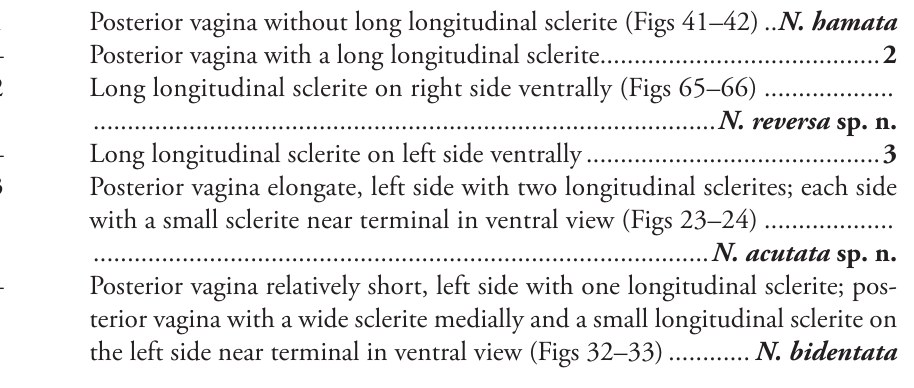
Key to species (males) of Neocarpia (revised from Zhang and Chen 2013) 1 Ventral margin of periandrium without spinose process .............................. 2 – Ventral margin of periandrium with one or two spinose process(es) ............ 3 2 Dorsal margin of periandrium with one process; flagellum with two pro- cesses near apex and without process at base (Emeljanov and Hayashi 2007: Figs 23–24) ............................................................................ N. okinawana – Dorsal margin of periandrium without process; flagellum with one process near apex and a long process near base (Figs 54–55) ........... N. reversa sp. n. 3 Ventral margin of periandrium with one small triangular process at basal 1/3 ... 4 – Ventral margin of periandrium without triangular process at base, while with one or two process(es) near or at apex ......................................................... 5 4 Left side of periandrium with a process near apex, dorsal margin with a shovel- shaped process, right side without process in the middle, base of process near apex of flagellum with two denticulations (Zhang and Chen 2013: Figs 10–11); forewing without stripe ............................................................. N. bidentata – Left side of periandrium without process, dorsal margin without process, right side with a short acute process in the middle, base of process near apex of flagellum without denticulation (Figs 12–13); forewing with yellow stripes along the Y-veins ................................................................ N. acutata sp. n. 5 Flagellum with a prominent long process in the middle (Löcker et al. 2010: Fig. 17A) ............................................................................. N. rhizophorae – Flagellum without process in the middle ..................................................... 6 6 Dorsal margin of periandrium with a hook-shaped process, ventral margin of periandrium with one process, flagellum with smooth apical margin (Zhang and Chen 2013: Figs 23–24) ....................................................... N. hamata – Dorsal margin of periandrium without process, ventral margin of perian- drium with two processes, flagellum with sinuate apical margin (Tsaur and Hsu 2003: Fig. 6D) ......................................................................... N. maai